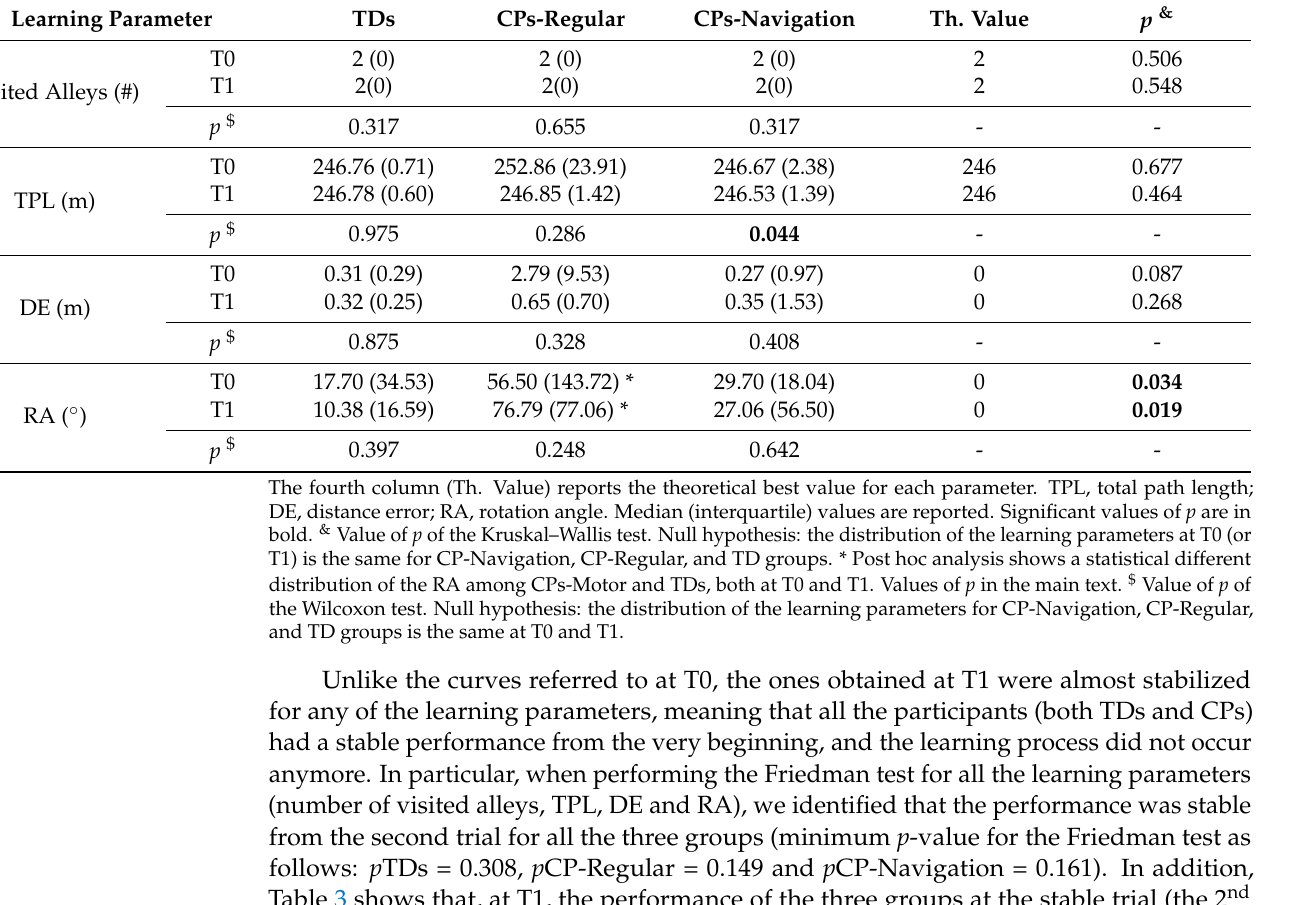
Table 3. Learning data at the stable trial for TDs (fifth trial at T0, second trial at T1), CPs-Motor (seventh trial at T0, second trial at T1), and CPs-Navigation (seventh trial at T0, second trial at T1), both at T0 and